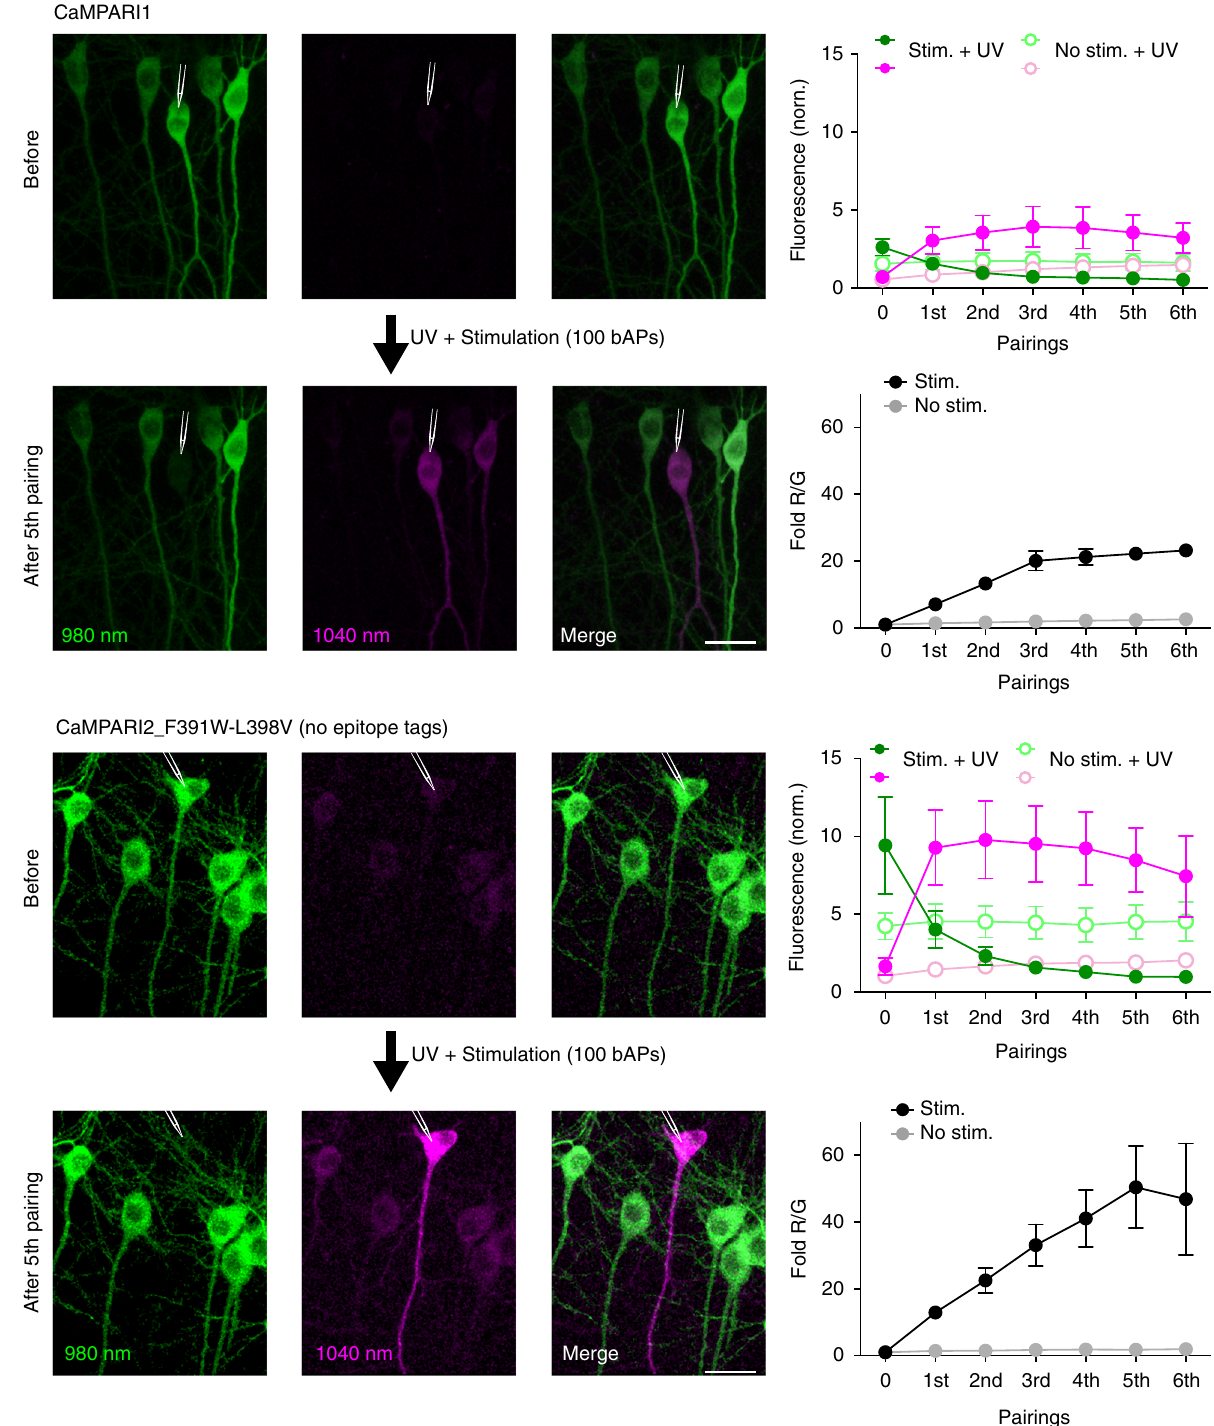
Fig. 2 Brightness and photoconversion of CaMPARI1 and CaMPARI2. Two-photon images of CaMPARI1 and CaMPARI2_F391W-L398V (no epitope tags) expressed in CA1 neurons of rat hippocampal slice cultures before and after pairing of stimulation (100 bAPs at 100 Hz) with UV light (2 s, 16 mW mm − 2 ). Two lasers were simultaneously employed to acquire images of the green (980 nm) and red species (1040 nm) of the CaMPARI variants. A single cell, denoted by a pipette drawing, is patched and stimulated during the UV illumination. Green and red fl uorescence is quanti fi ed along with the fold R/G in both stimulated (CaMPARI1 n = 5; CaMPARI2 n = 6) and unstimulated neighboring neurons (CaMPARI1 n = 5; CaMPARI2 n = 14) as a function of the number of pairings. Error bars are SEM. Note that fl uorescence intensity is normalized to the laser power (see Methods), showing the increased brightness of CaMPARI2. Scale bars are 25 µ